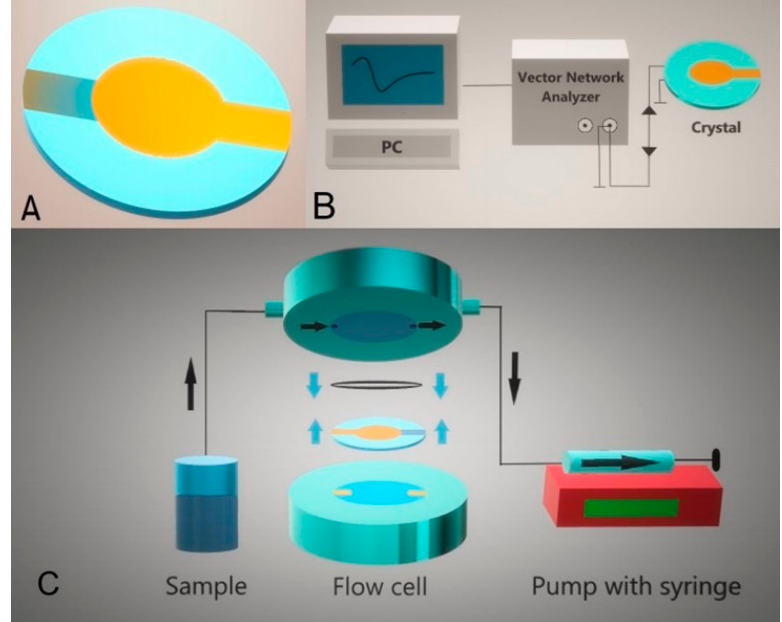
Figure 4. Schematics representation of the AT-cut quartz crystal with gold electrodes ( A ) and its implementation into the thickness shear mode (TSM) setting ( B ). Crystal is placed into the flow cell, and the liquid is added at the crystal surface using a syringe pump ( C ).